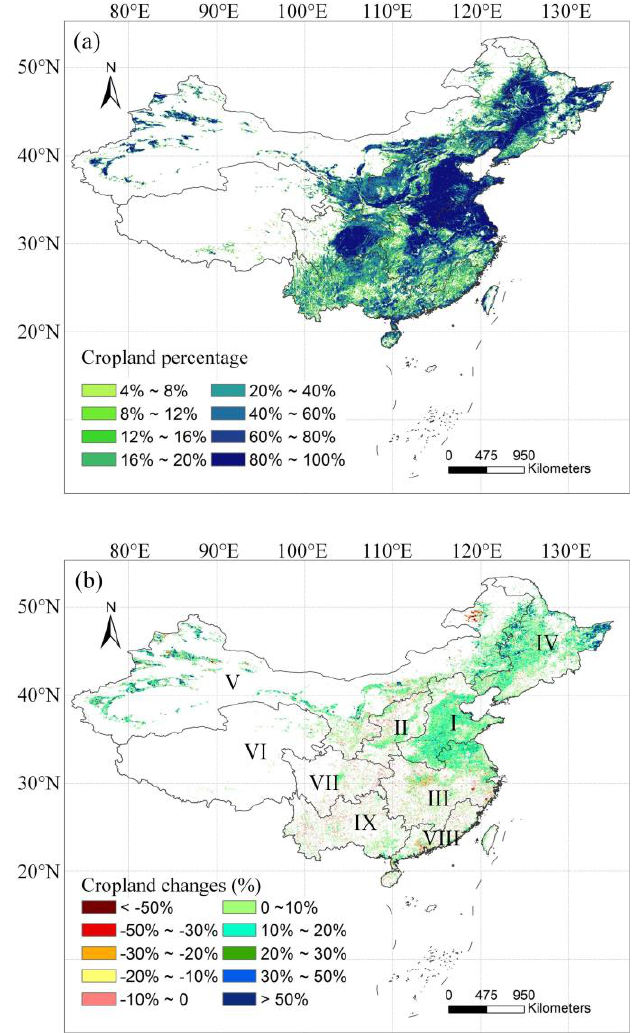
Figure 2. Spatial distribution of Chinese cropland percentage ( a ) and its changes ( b ) during the period 1980–2015: I, Huang-Huai-Hai Plain; II, Loess Plateau; III, middle–lower Yangtze Plain; IV, Northeast China Plain; V, northern arid and semi-arid regions; VI, Qinghai Tibet Plateau; VII, Sichuan Basin and its surrounding regions; VIII, Southern China; and IX, Yunnan-Guizhou Plateau.